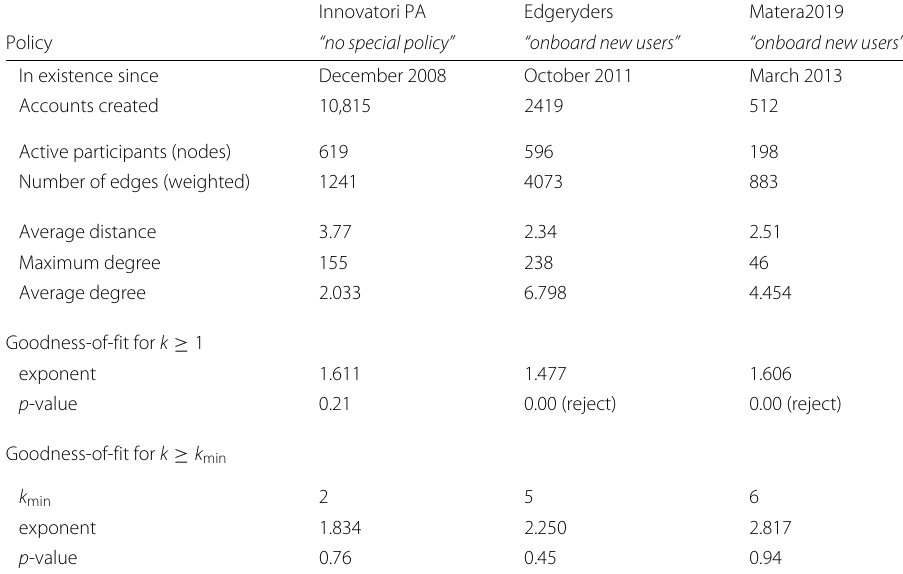
Table 1 Comparing interaction networks of the three online communities and testing for goodness-of-fit of power functions to degree distributions Innovatori PA Edgeryders Matera2019 Policy “nospecialpolicy” “onboardnewusers”